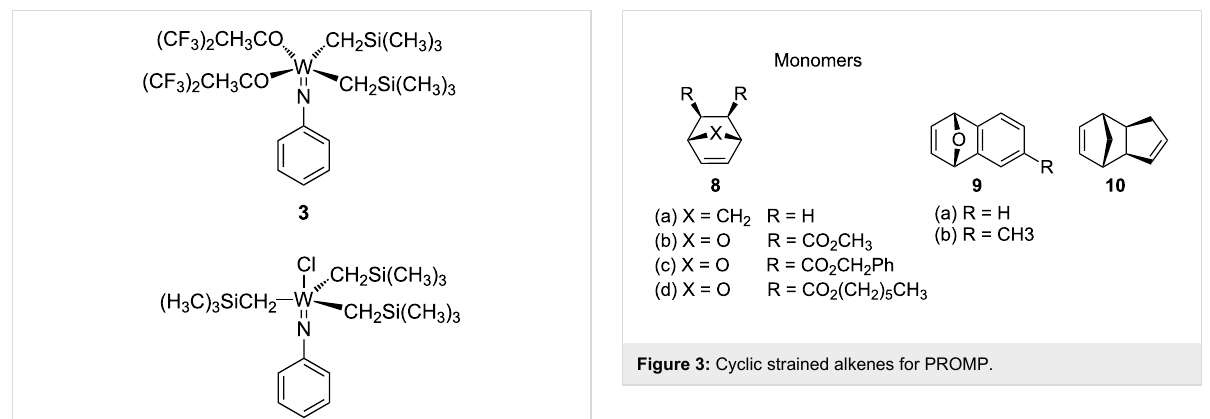
activity even at room temperature. UV irradiation at 364